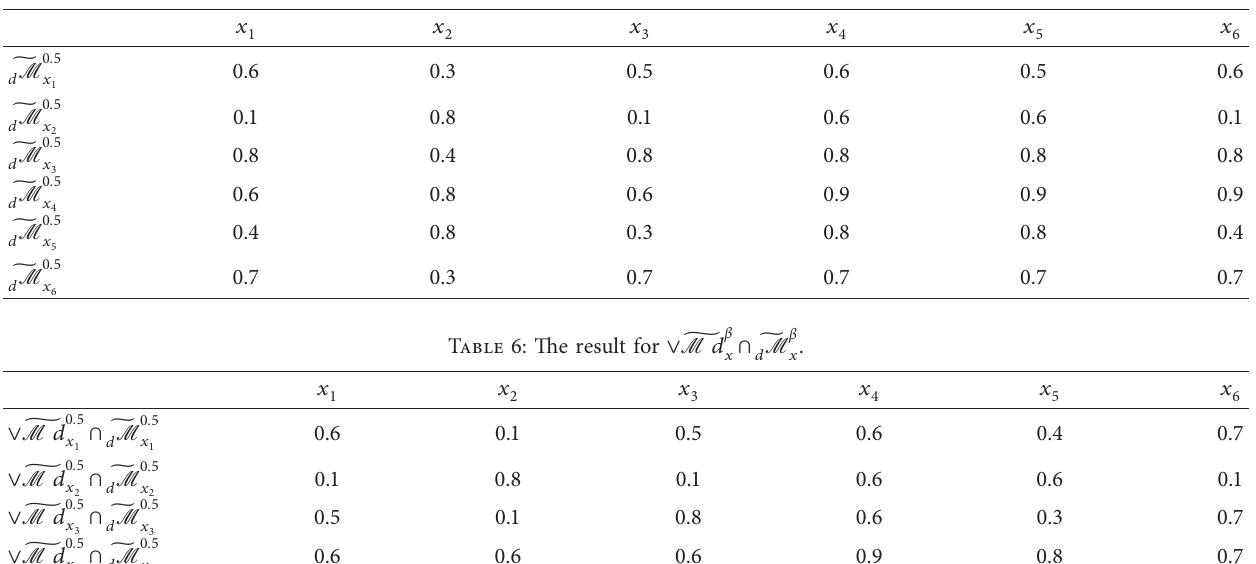
Table 5: Values of 􏽦